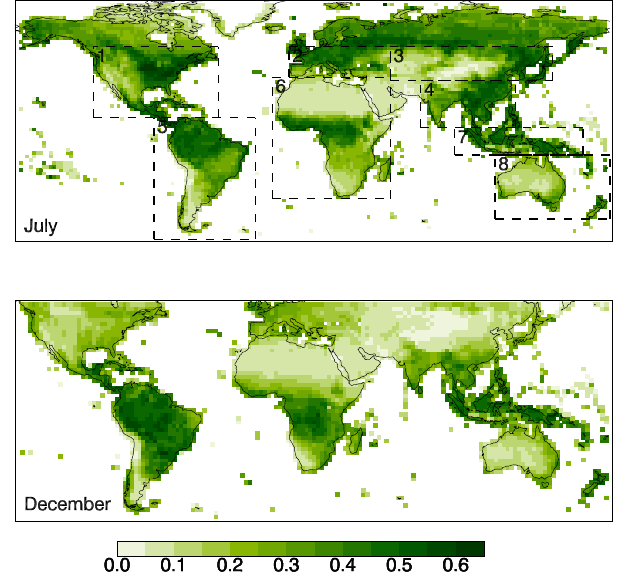
35 Fig. 11. Enhanced Vegetation Index (EVI) (unitless) from Aqua Fig. 11. Enhanced Vegetation Index (EVI) (unitless) from Aqua MODIS for July and December MODIS for July and December 2009. Boxes in top panel indicate 2009. Boxes in top panel indicate regions of interest that will be further explored in Figs. 14–15. regions of interest that will be further explored in Figs. 37